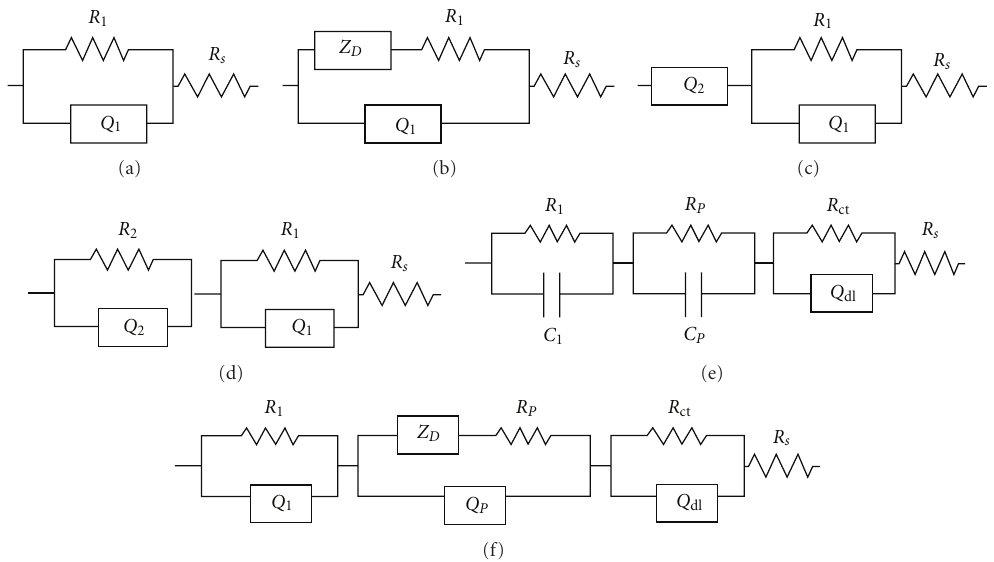
Figure 5: Physical models for metal/passive film/solution system: (a) Model A, (b) Model B, (c) Model C, (d) Model D, (e) Model E, and (f) Model F.